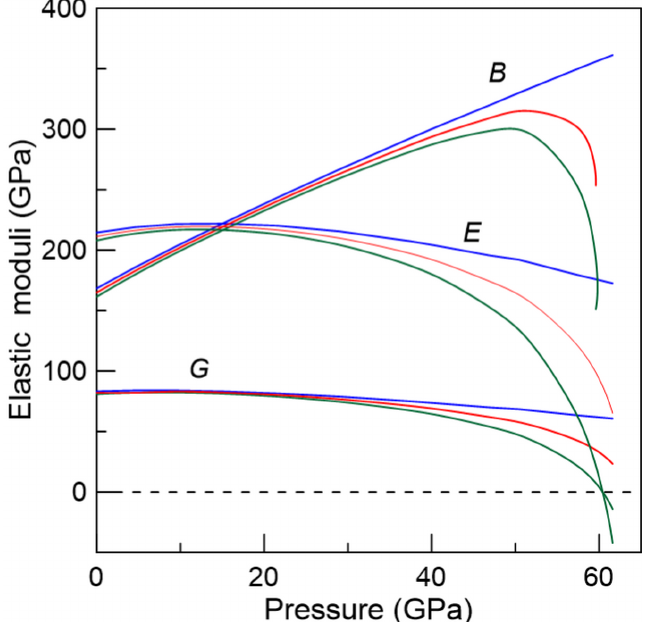
Figure 7. Pressure evolution of the elastic moduli: bulk modulus B , Young modulus E , and Shear modulus G of DyScO 3 perovskite. The blue line represents the moduli in the Voigt approximation, the green line in the Reuss approximation, and the red one in the Hill